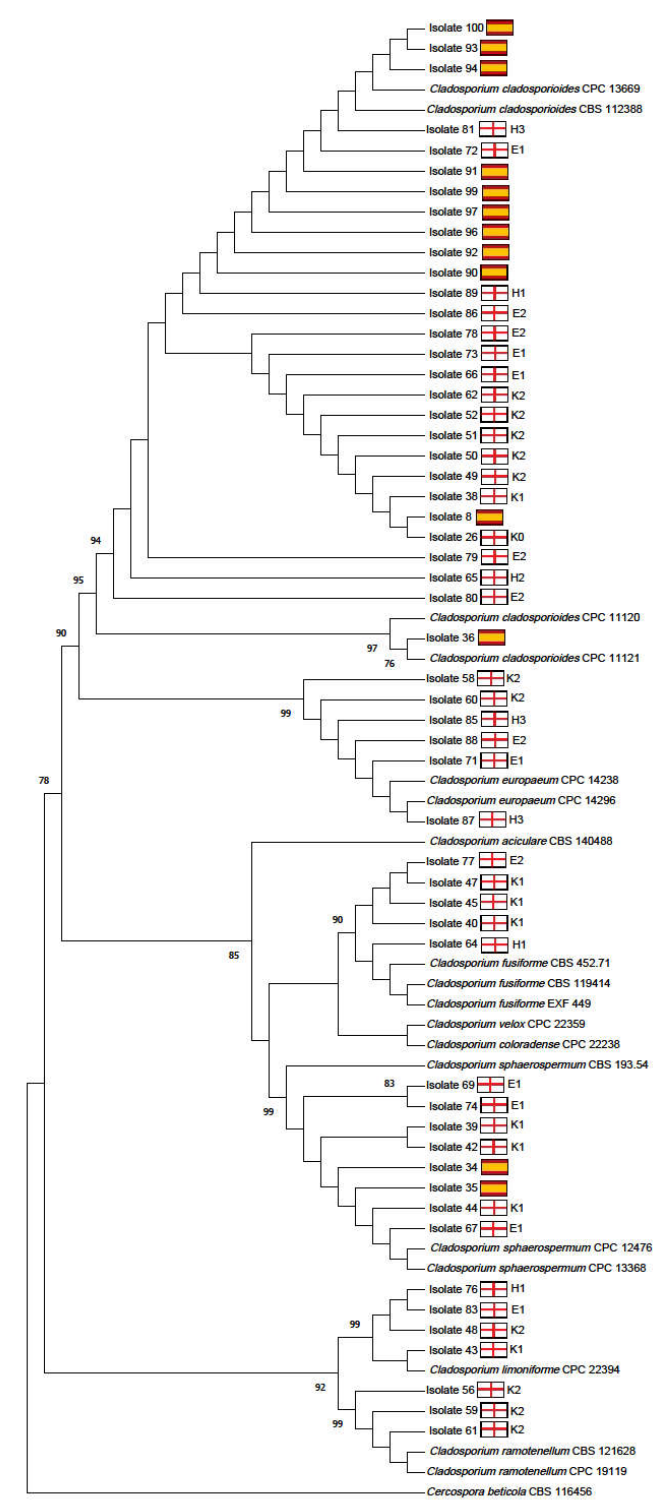
Figure 2. A phylogenetic tree of the ACT gene for 72 isolates of Cladosporium . The tree was created using maximum likelihood with a Kimura 2-parameter evolutionary model and 1000 bootstrap replications. The numbers above branches represent bootstrap values. The flags represent the country of origin, the codes represent areas within the country and numbers denote different farms. Area codes are as follows: E = Essex, K = Kent, H = Herefordshire.